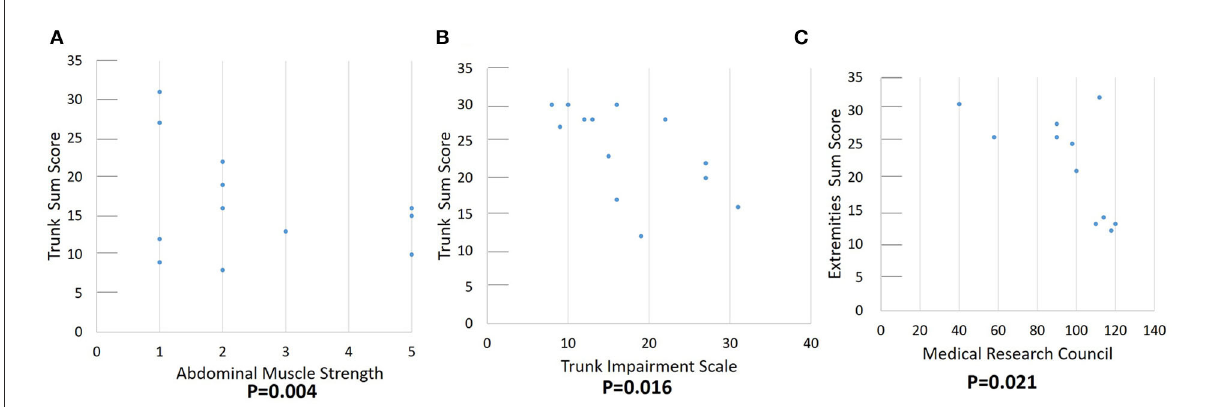
FIGURE4 Correlation of function score and quantitative echogenicity severity of skeletal muscles. (A,B) demonstrate a significant correlation between total echo trunk sum score and abdominal muscle strength and trunk impairment scale. (C) demonstrates a significant correlation between MRC and total echo extremities sum